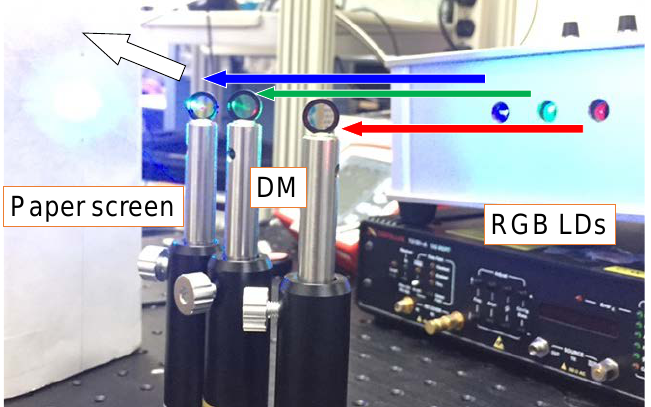
Figure 2. Experimental photo of the proposed OFDM-NOMA VLC system using RGB LDs. White light can be produced by combining the RGB light via a dichroic mirrors (DMs). Arrows indicate the directions of the R, G, B optical beams and the combined white light.